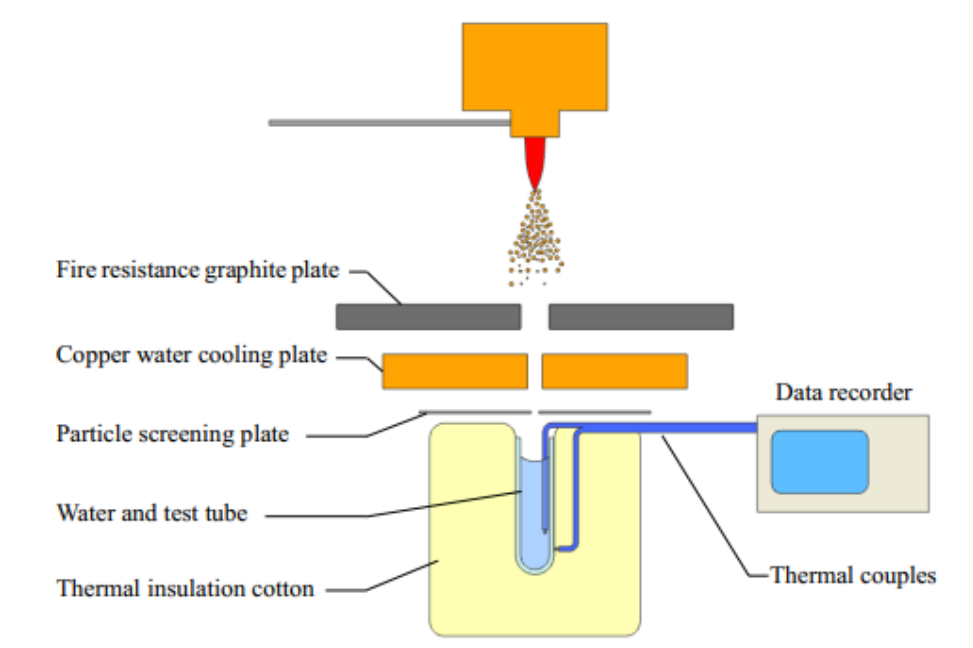
Figure 5. Schematic of particles temperature measuring equipment.